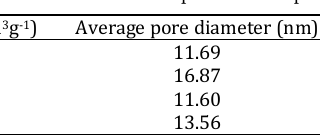
Fig. 4. Adsorption-desorption isotherm for different N-doped TiO2